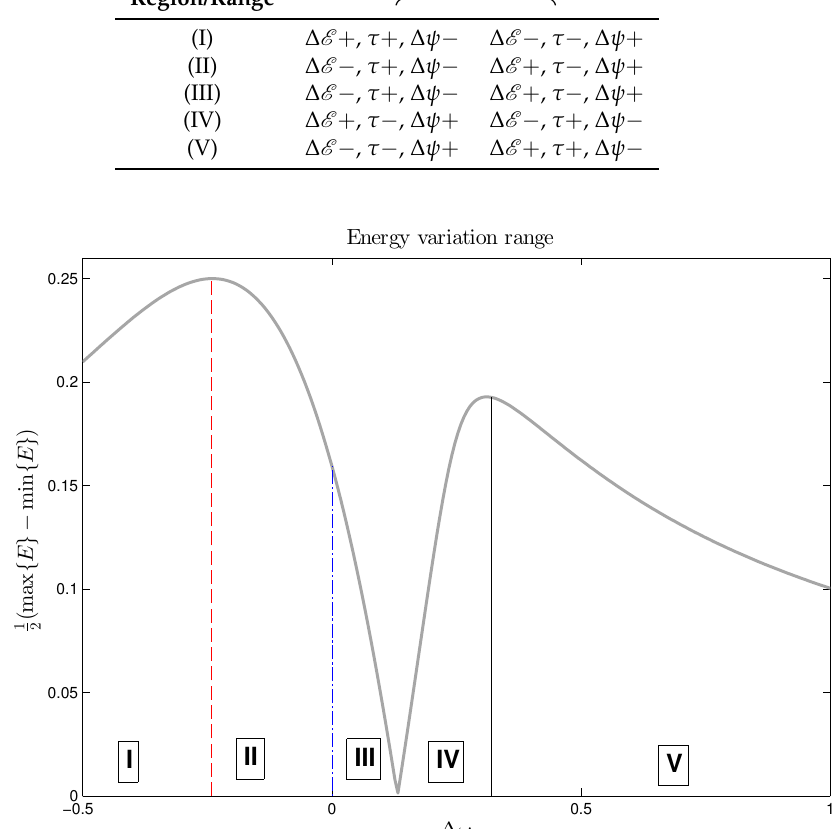
Figure 2. Typical dependency of the energy variation range ∆ E on the frequency detuning ∆ ω for the case when the high frequency mode ω 3 has the maximal energy (initial condition from Table 1). ( 1 ) The vertical red dashed line shows the location of ∆ ω max , while the vertical black solid line shows the ( 2 ) location of ∆ ω max . Finally, the blue dash-dotted line shows the amplitude obtained the exact